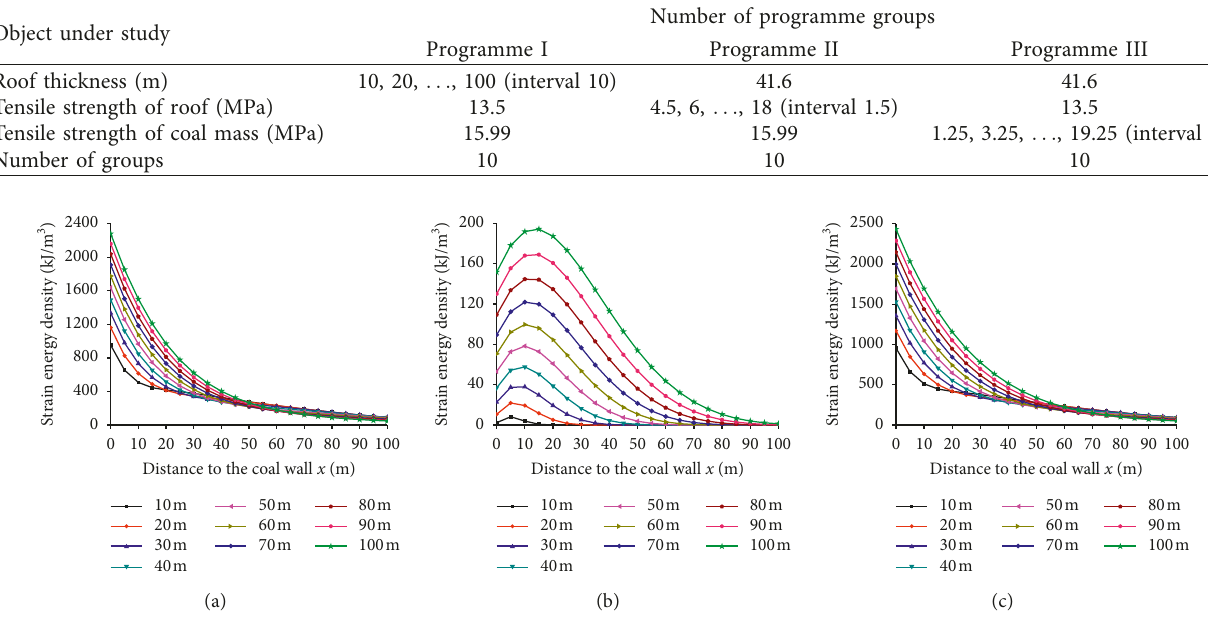
Figure 8: Roof strain energy densities before the initial breakage event. (a) Coal mass. (b) Roof rock mass; (c) Overall working face.